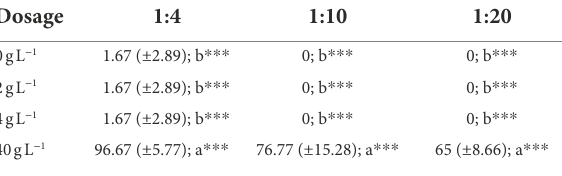
TABLE 2 Acute toxicity test results obtained after 48 h of exposure of D. magna at the soil leachates diluted 1:4, 1:10, and 1:20. Dosage